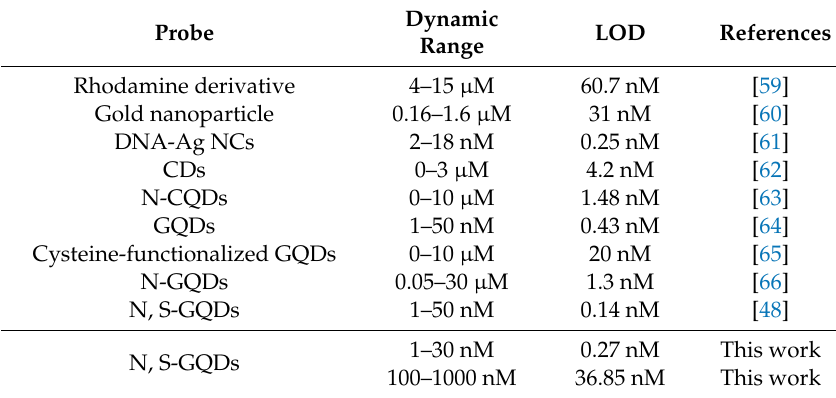
Table 3. Comparison of di ff erent fluorescence sensing systems for Hg 2 + detection.